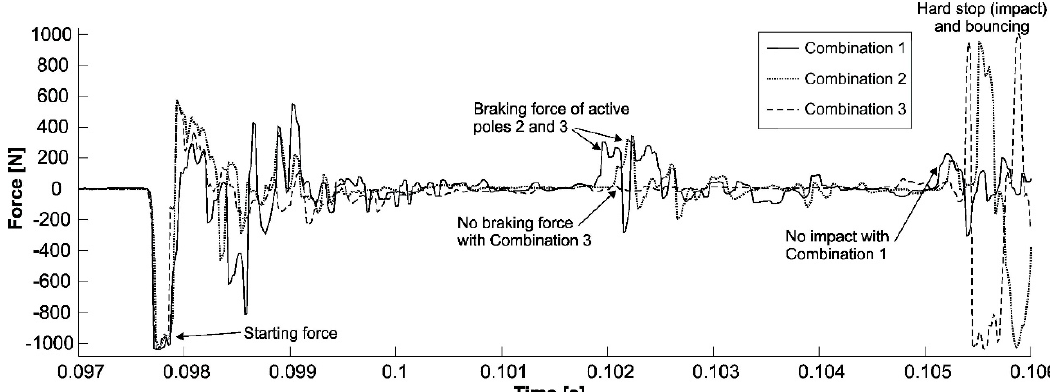
Figure 11. The comparison of the measured forces during the actuator stroke obtained with di ff erent excitation combinations.